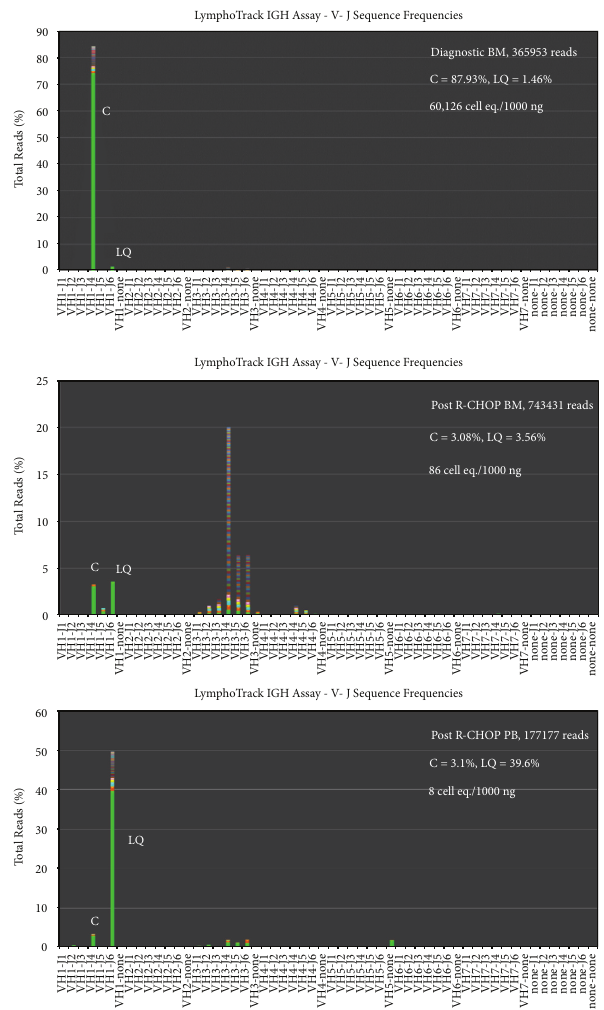
Figure 4: MRD after R-CHOP therapy. Clonal reads were detected at a low level in total DNA from bone marrow (BM) and peripheral blood (PB) and after R-CHOP therapy. The B-cell repertoire shows severe contraction in the peripheral blood after R-CHOP therapy. C: clonal and LQ: LymphoQuant. Table 2: Minimal residual disease detection by